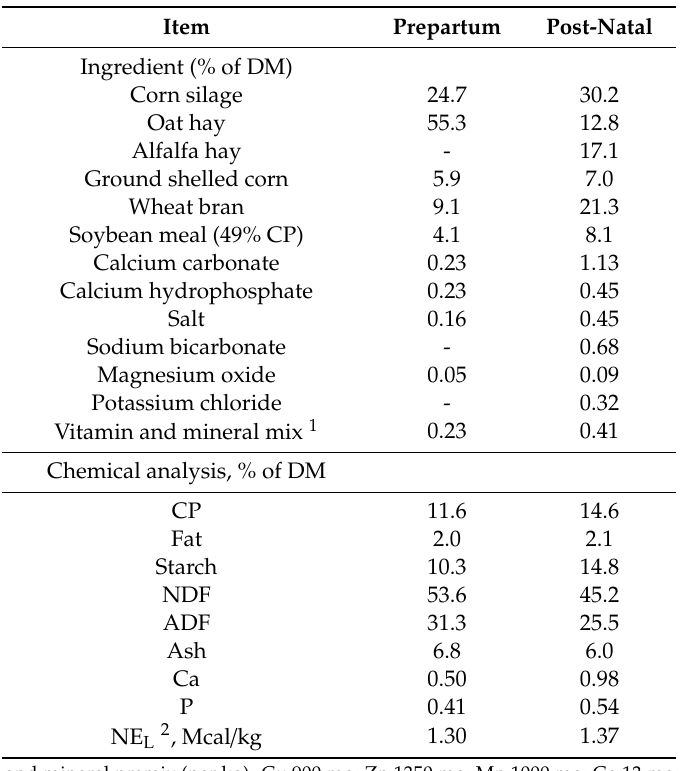
Table 1. Ingredients and nutrient composition of the